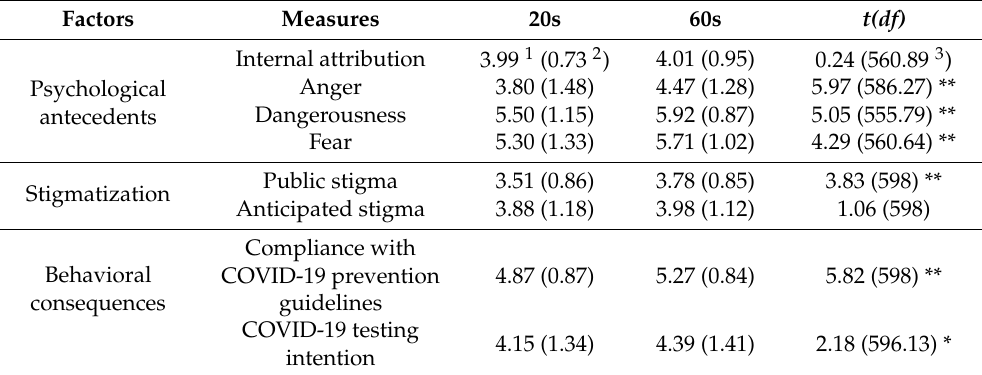
Table 1. A comparison of the measures between the two age groups. Factors